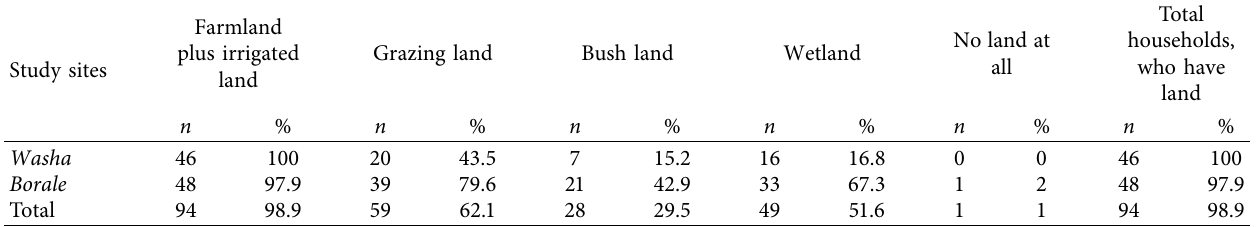
Table 3: Number of households who had different land use types across the study sites.